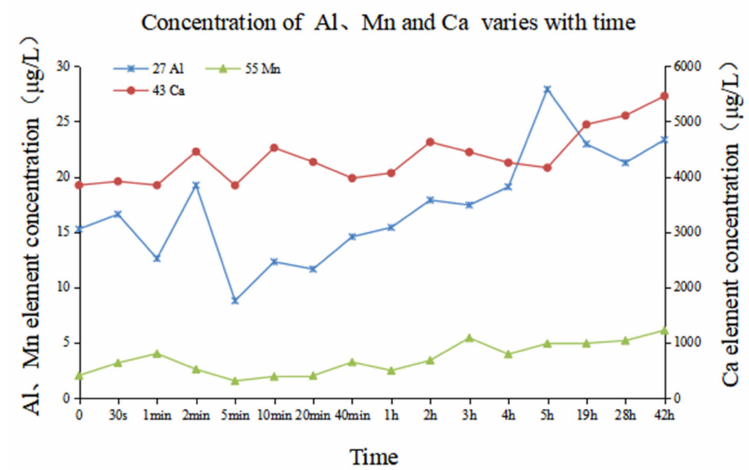
Figure 6. In UF water the effects of suspended particulate matter at different time adsorption and release of Ca, Mn and Al.